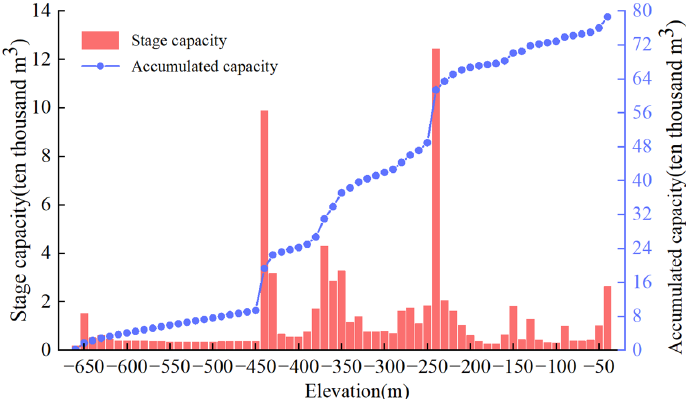
Figure 4. Distribution of available underground space in the Shitai Mine.